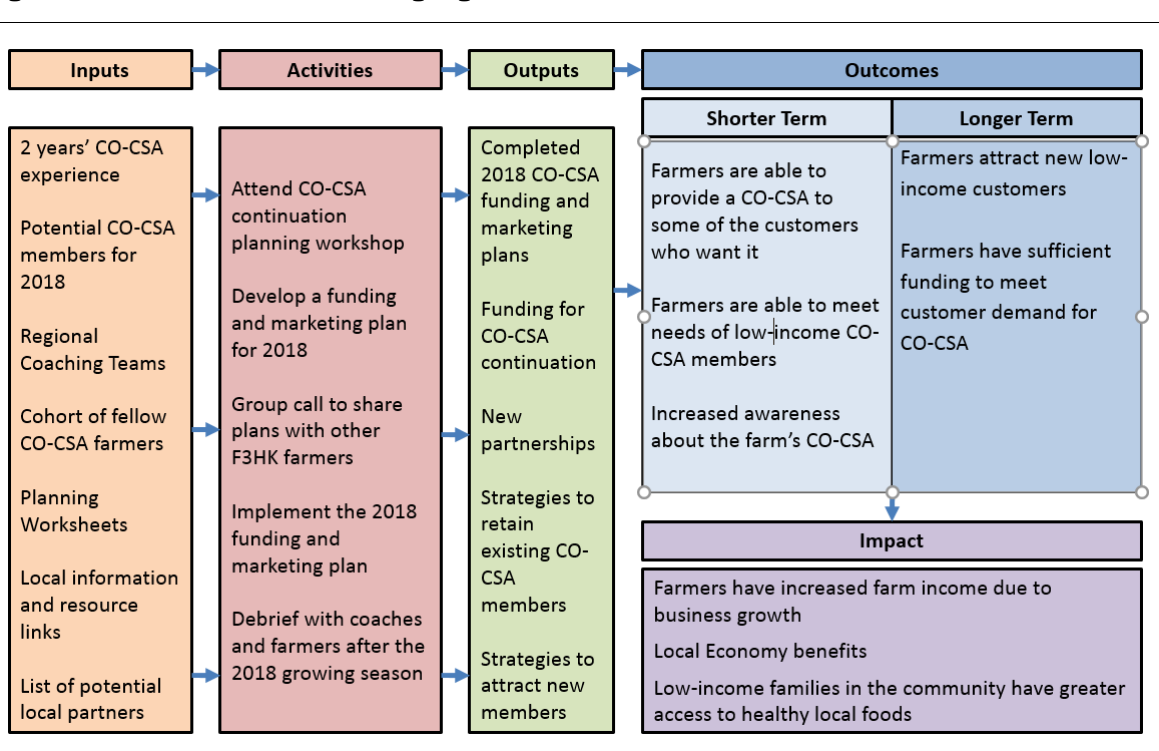
Figure 2. CO-CSA Continuation Planning Logic